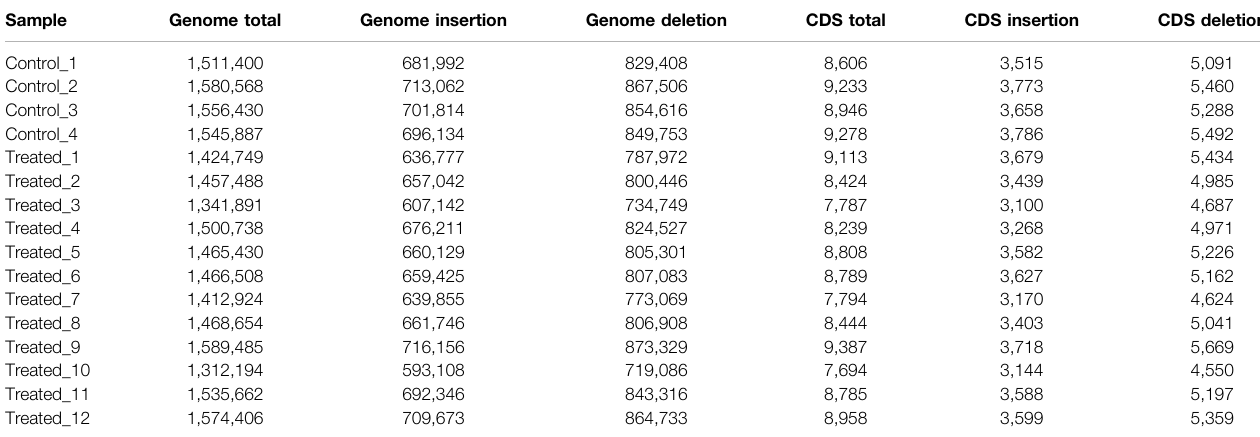
TABLE 7 | InDels in the control and EMS treatment group after calling.